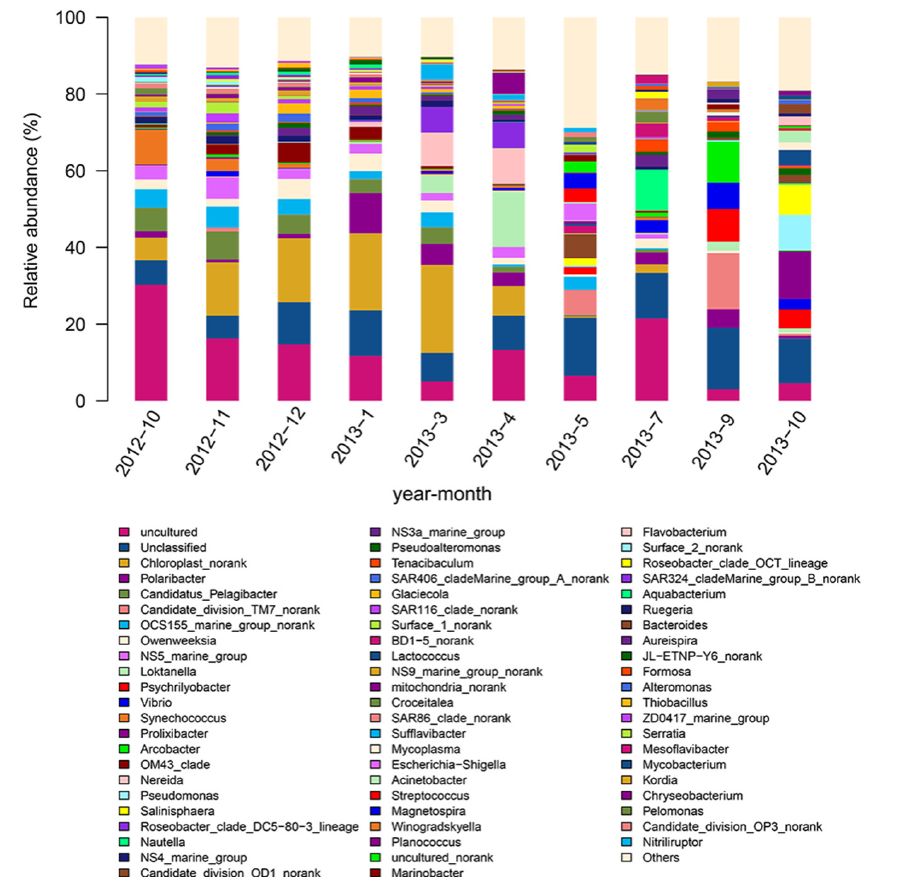
Figure 3. Genus-level abundance of bacterial community in samples of open sea seawater in different months.